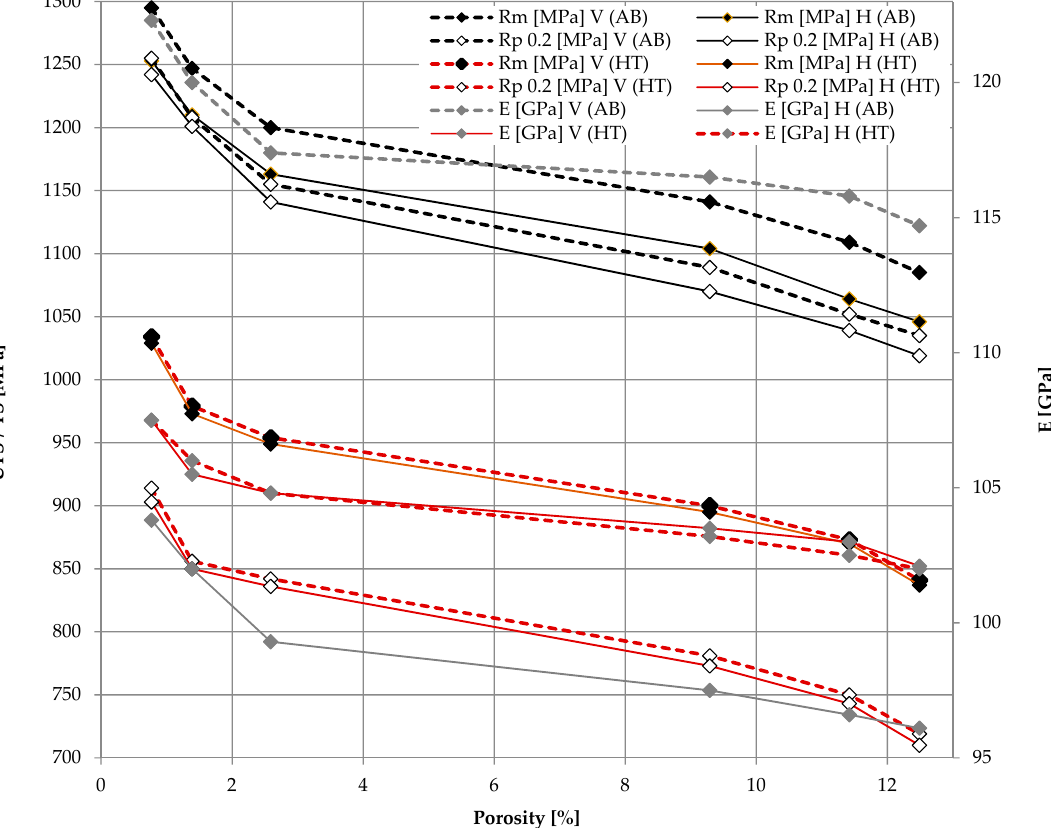
Figure 7. Anisotropic properties of samples built with different orientation.